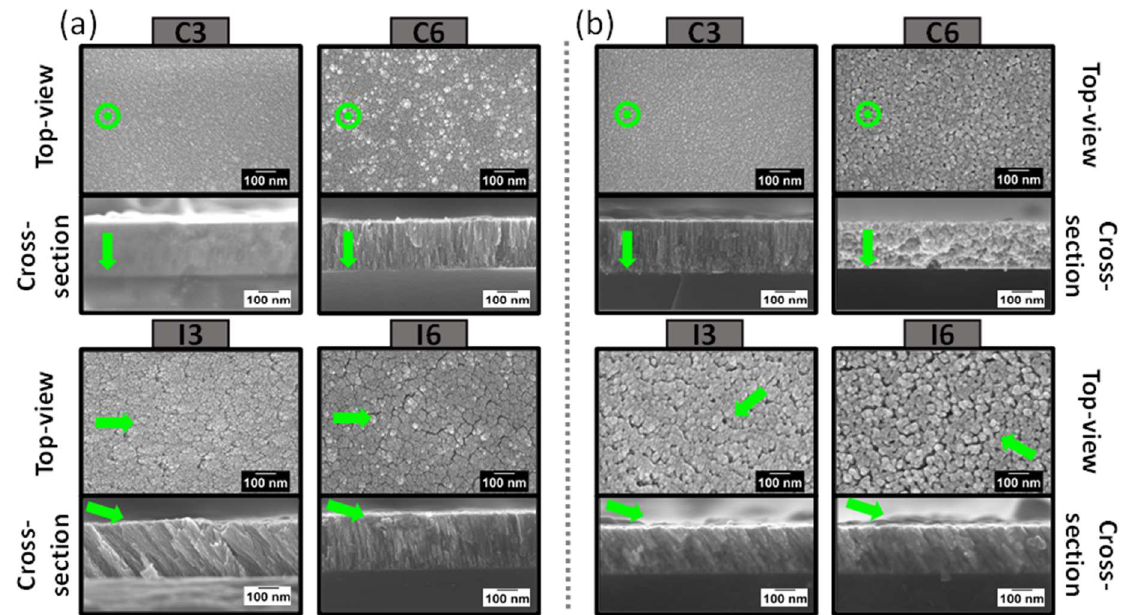
Figure 1. Top and cross-section views of SnO 2 thin films sputter deposited on silicon ( a ) before and ( b ) after an annealing treatment in air for 48 h at 500 °C. Arrows indicate the incoming particle flux during the deposition.